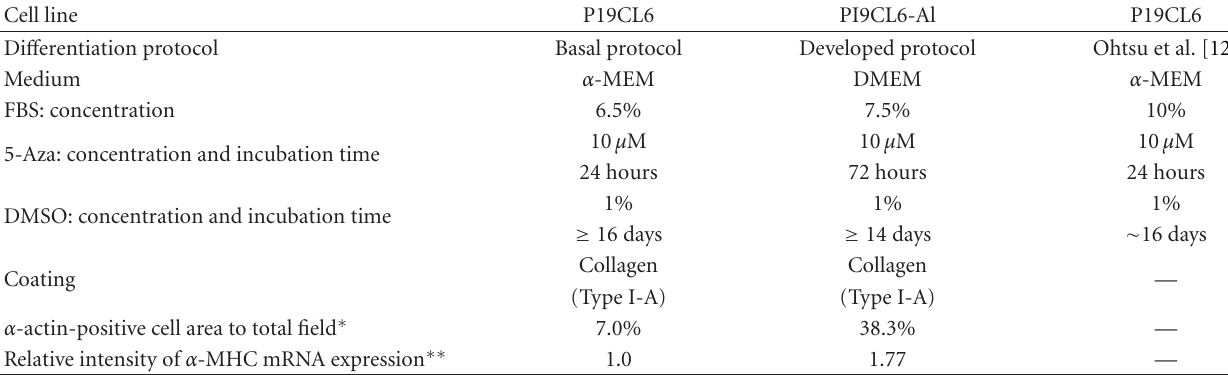
Table 1: The conditions of di ff erentiation protocol and di ff erentiation e ffi ciency for P19CL6 and P19CL6-A1